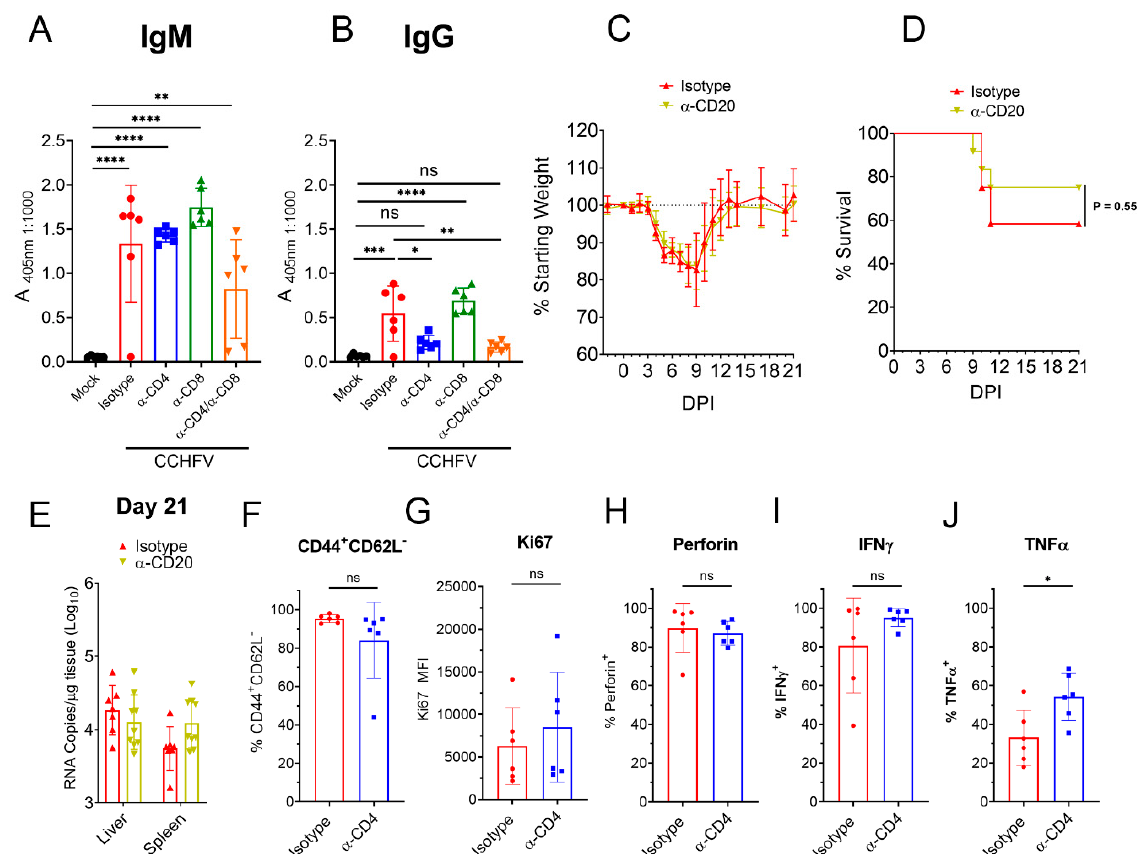
Figure 5. Depletion of CD4 + T-cells impairs early antibody but not early CD8 + T-cell responses. IFNAR − / − mice were infected with CCHFV and on day +8 PI CCHFV-specific IgM ( A ) or IgG ( B ) measured by whole-virion ELISA. N = 5–6 per group. Indicated statistical comparison performed with one-way ANOVA with Tukey’s multiple comparisons test. ( C – E ) CCHFV-infected IFNAR − / − mice were treated with α -CD20 or isotype control and weighed daily ( C ) and monitored for survival ( D ). ( C , D ) N = 12 per group. ( D ) p value calculated with Log-rank test. ( E ) At day 21 PI, viral loads in liver and spleen quantified by qRT-PCR. N = 6 per group. ( F – J ) At day 8 PI, CD8 T-cells in the liver of IFNAR − / − mice treated with isotype or antibody to deplete CD4 T-cells were evaluated for their surface expression of CD44, CD62L ( F ) and expression of Ki67 ( G ). ( H ) CD8 T-cells were analyzed for their expression of perforin after 4 h incubation in presence of brfA. ( I , J )